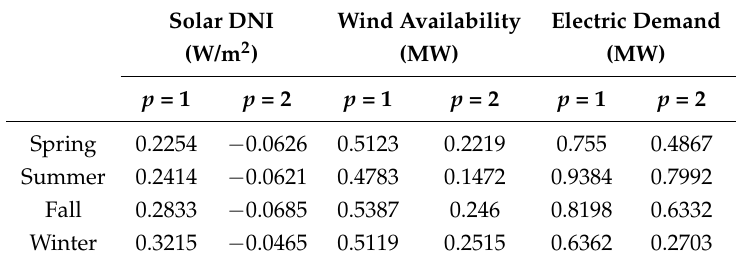
Table 2. Autocorrelations of Stationary Base Process, Z t , With Lag p